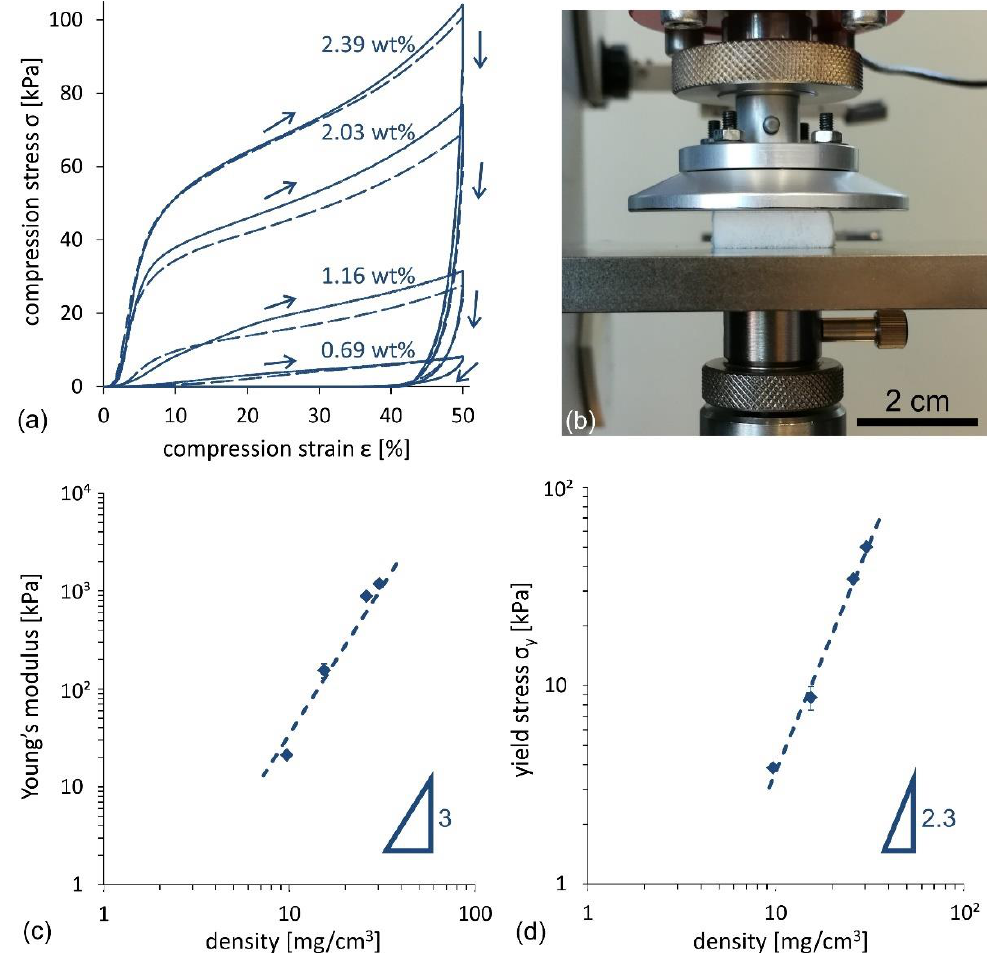
Figure 7. Mechanical compression tests for CNF foams produced by the stirred freezing process. ( a ) Compression stress as a function of compression strain up to 50%. The numbers refer to CNF suspension concentrations of 0.69 wt%, 1.16 wt%, 2.03 wt%, and 2.39 wt%. Two lines (solid and dashed) refer to two different tests on two different samples. ( b ) Picture of the experimental setup. ( c , d ) Evaluation of the Young’s modulus ( c ) and the yield stress ( d ) as a function of foam density.